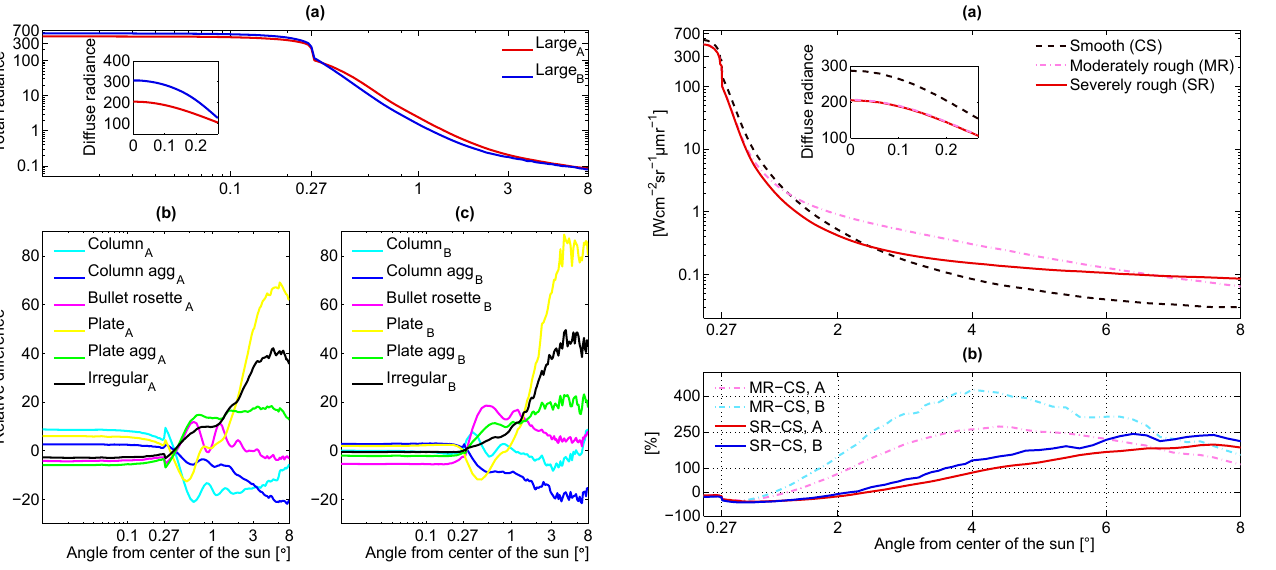
Figure 10. Impact of the shape of large severely rough ice crystals on the disk and circumsolar radiances. (a) The total radiances based on the large A and large B distributions. (b, c) The relative differ- ences of the radiances based on the six single-habit distributions of flight A or B and the large A or large B , respectively. All the simula- tions are conducted with τ a = 0 . 09 and τ c = 1 . 6.